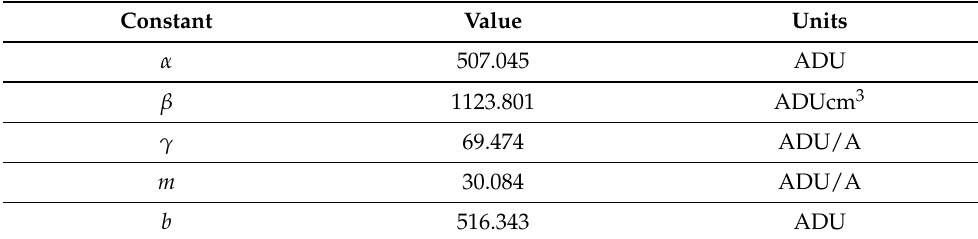
Table 5. Optimized sensor